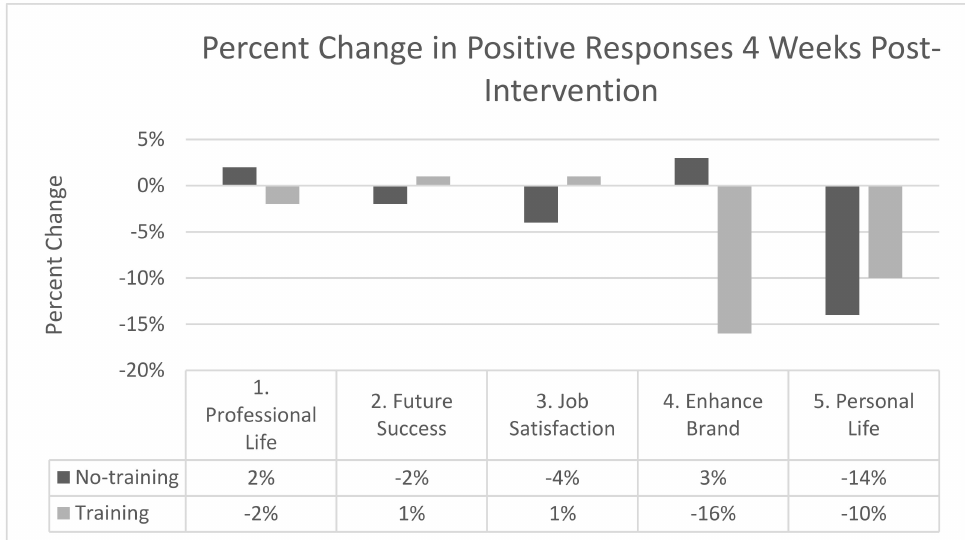
Figure 8. Percent change in positive responses for the sustainability engagement index items from the post- to the 4-week post-intervention measurement time